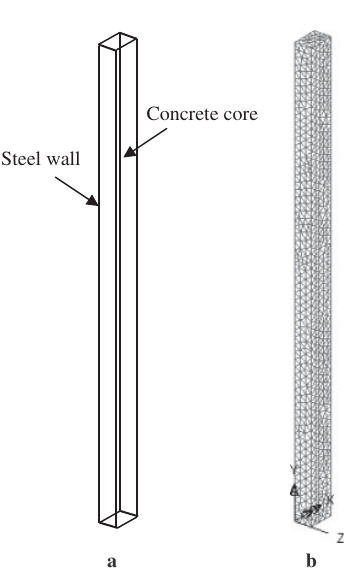
Fig. 3. Typical CFSC slender column in this study: (a) geometry, (b) finite element